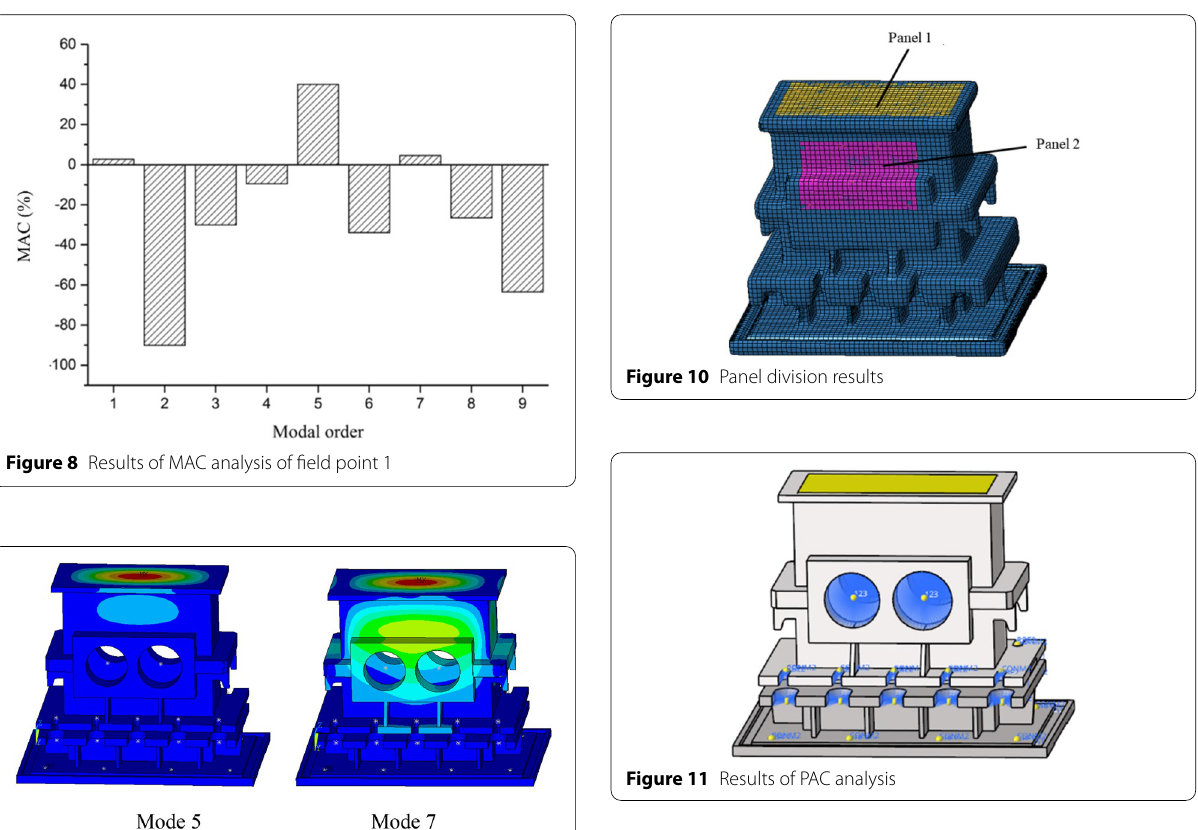
Figure 9 5th and 7th order modal shape diagrams